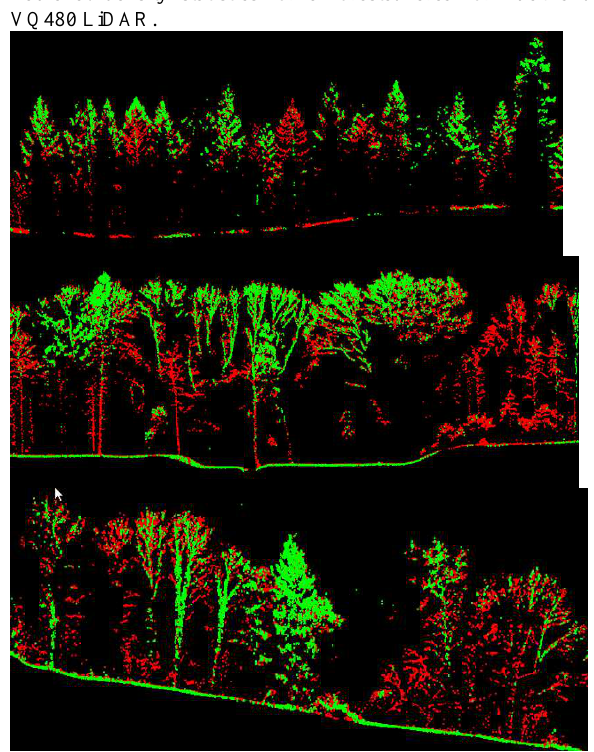
Figure 15: 1m width cross section in canopy for zone 3 (up), 2 (middle) and 1(bottom). Green=Puck,